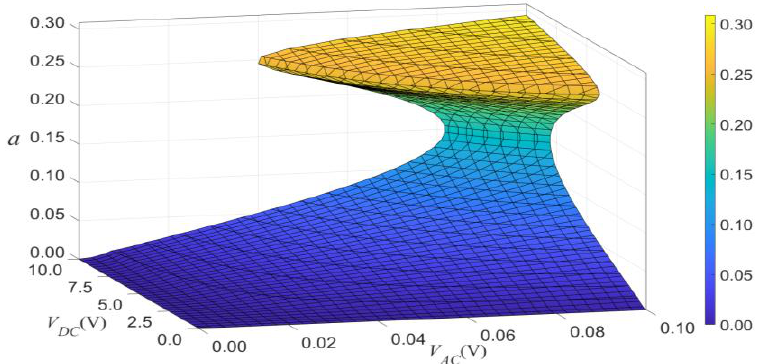
Figure 18. The 3D plot of amplitude of the response as a function of the load’s amplitude of primary resonance for σ = 0.05.